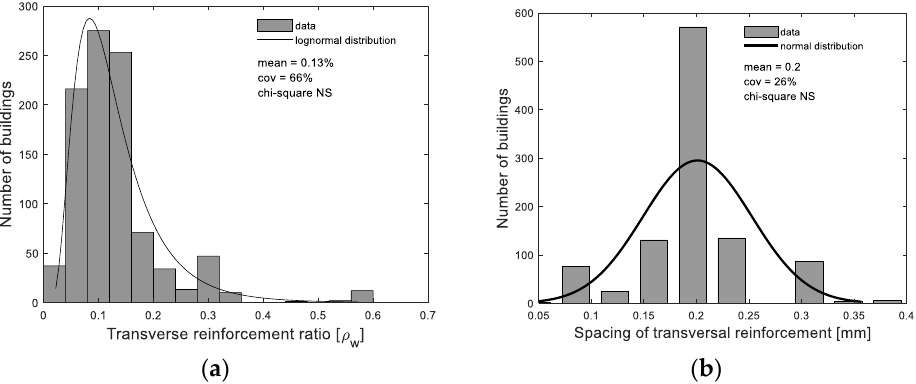
Figure 17. Distribution of buildings regarding columns′ ( a ) transverse reinforcement ratio (%) and ( b ) transverse reinforcement spacing for all RC buildings.